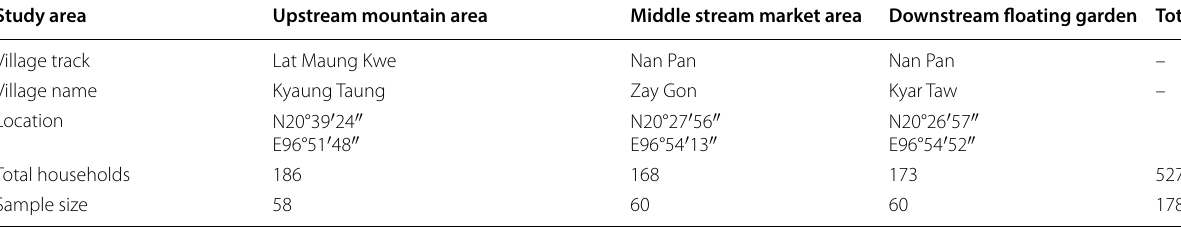
Table 2 Summary of land cover statistics for 1989, 2000 and 2014